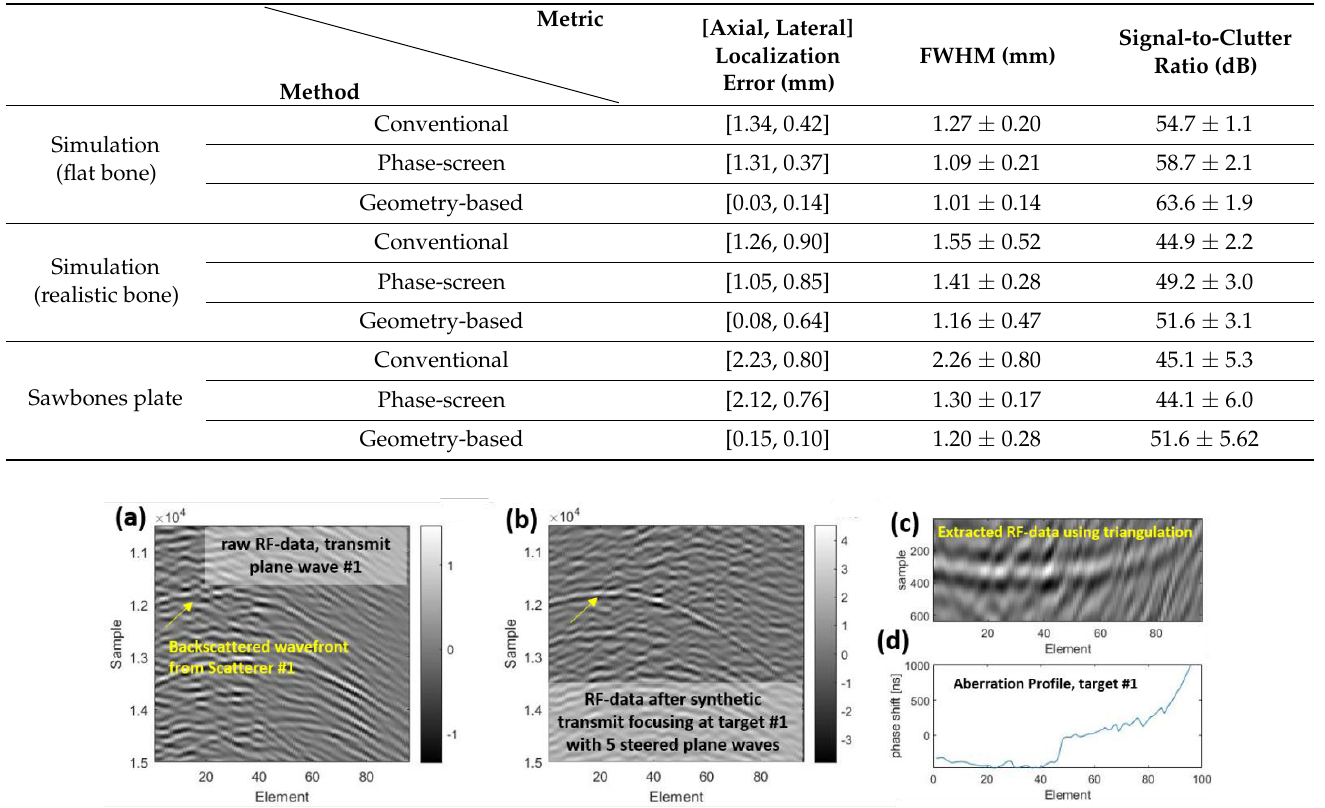
Figure 5. The reconstructed numerical images using ( a ) conventional beamforming, ( b , c ) phase-screen modeling, and ( d ) geometry-based reconstruction techniques with a flat bone model (Figure 3a). The aberration profile (AP) was estimated using the dataset generated with a ( b ) homogeneous and ( c ) heterogeneous background wave-speed model. The red dots indicate the true location of the scatterers. The blue triangles in ( b ) indicate the region that was used as background for quantifying the signal-to-clutter ratio calculation in Table 1. The yellow boxes in ( c ) indicate the regions at which the scatterers are completely missed. The lateral FWHM ( e ) and signal-to-clutter ratio ( f ) and localization error ( g ) obtained with all the methods for each scatterer. Table 1. Quantitative evaluation of the numerical and experimental results presented in Figures 4, 6, and 7.